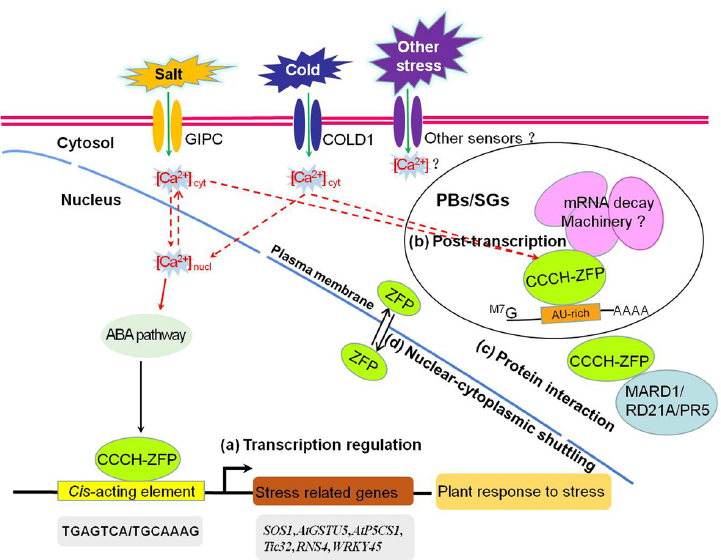
Figure 1. Putative regulatory mechanism by which CCCH zinc-finger proteins mediate abiotic stress tolerance in plants. ( a ) Transcription regulation of CCCH zinc-finger protein in the nucleus under abiotic stress. ( b ) Post-transcriptional regulation of CCCH zinc-finger protein in processing bodies (PBs) and stress granules (SGs) of the cytoplasm under abiotic stress. ( c ) Protein interaction of CCCH zinc-finger protein in the cytoplasm under abiotic stress. ( d ) Shuttling of CCCH zinc-finger protein between the nucleus and cytoplasm under abiotic stress. Solid arrows indicate processes that have been verified, and dotted arrows indicate processes that need to be clarified.